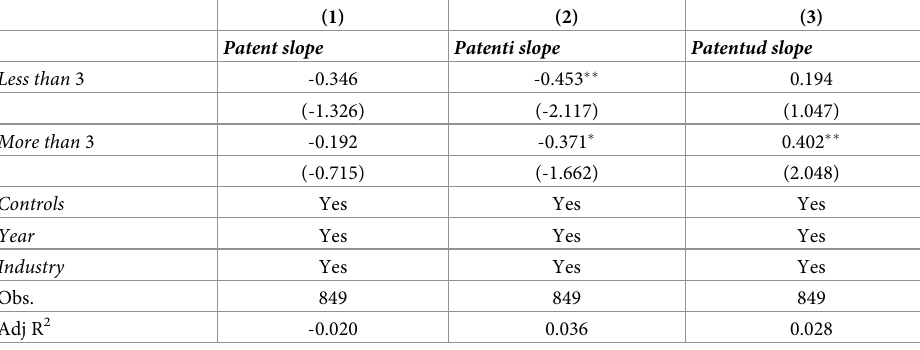
Table 9. Equity incentive and innovation output: All sample firms.